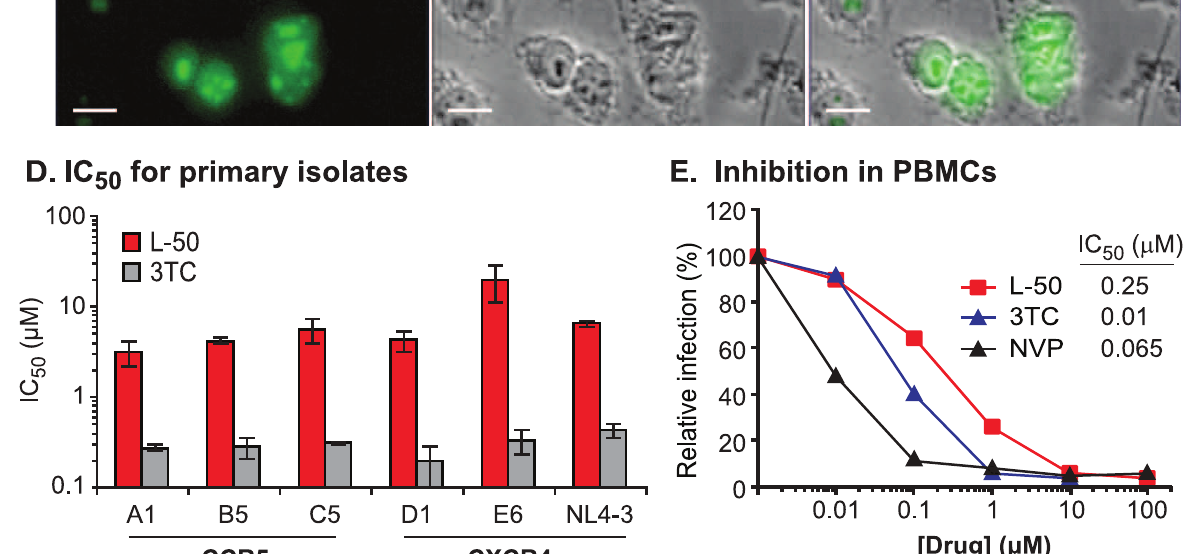
Figure 2. Testing the susceptibility of HIV-1 to inhibition by Tat peptidomimetics. ( A ) Comparison of the relative inhibition of the HIV-1 NL4-3 laboratory strain by three lead Tat peptidomimetics. Virus production in cell free supernatant was measured using an endogenous RT assay. ( B ) The concentration for 50% inhibition (IC 50 ) of HIV-1 NL4-3 was calculated for the lead Tat peptidomimetics and for the reference antiretroviral, 3TC. ( C ) Cell penetration (hT4R5 fibroblasts) and nuclear localization of fluorescein-labeled L-51 peptide analyzed by confocal microscopy. ( D ) L-50 inhibition of viral replication of three primary CCR5-tropic HIV-1 isolates measured in U87.CD4.CCR5 cells (A1 is the subtype A Rawandan isolate A1- 92RW009, B5 is the subtype B isolate B5-91US056 from the USA and C5 is the subtype C isolate C5-97ZA003 from South Africa) and of CXCR4-tropic strains (D1 is the Ugandan subtype D isolate D1-92UG021, E6 is the subtype A/E circulating recombinant isolate CRF01_AE from Thailand) as well as the laboratory strain HIV-1 NL4-3 measured in U87.CD4.CXCR4 cell cultures. The IC 50 values for L50 and 3TC were calculated from drug susceptibility curves (Figure S1). ( E ) Inhibition of HIV NL4-3 was also measure in human peripheral blood mononuclear cells stimulated with PHA/IL-2. The nucleoside RT inhibitor, 3TC or the non-nucleoside RT inhibitor, nevirapine (NVP) were used as controls. Virus production was measured at 8 and 10 days post-infection by the RT activity in the supernatant (cpm/mL). doi:10.1371/journal.ppat.1002038.g002 Early-stage drug candidates often display efficient HIV-1 inhibition was actually increased in human PBMCs (IC 50 inhibition in cell lines but lack potency in primary CD4 + T lymphoctyes. In the case of L-50, the efficiency of HIV-1 NL4-3